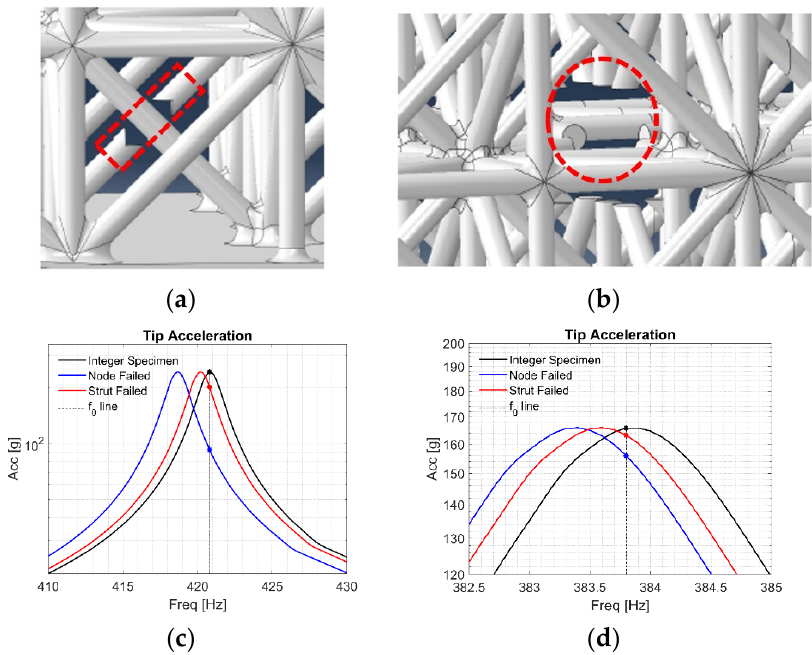
Figure 5. Detailed view of the damage families considered in this work for the FCC lattice configuration. ( a ) Broken strut and ( b ) missing node. ( c , d ) FRF of the as-designed (black line) and induced-damage geometry (red and blue lines) for FCC and diamond cell respectively. Table 5. Reduction of frequency and tip acceleration under resonant conditions through numeri- cal